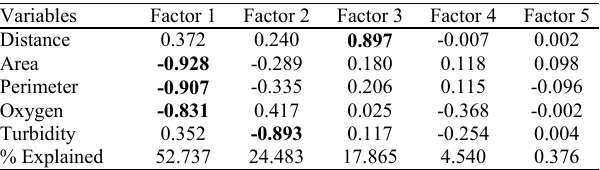
Table 2. Factor loadings from the Principal Component Analysis with five environmental variables of lakes.